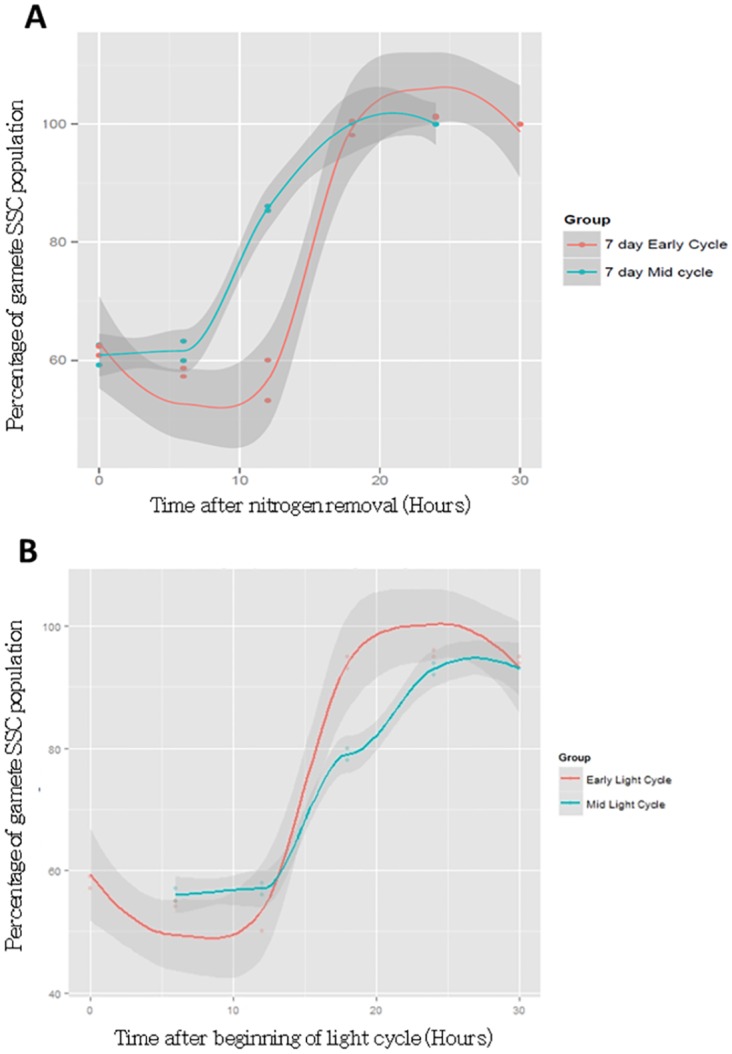
Phase in light cycle at which nitrogen is removed influences the dynamics of gametogenesis.A) Comparison of percentage of cellular events occupying the gametic gate (low Side-scatter gated on gametic population) over the course of gametogenesis, with respect to the time since nitrogen removal. B) Comparison of percentage of cellular events occupying the gametic gate over the course of gametogenesis, with respect to the light cycle.